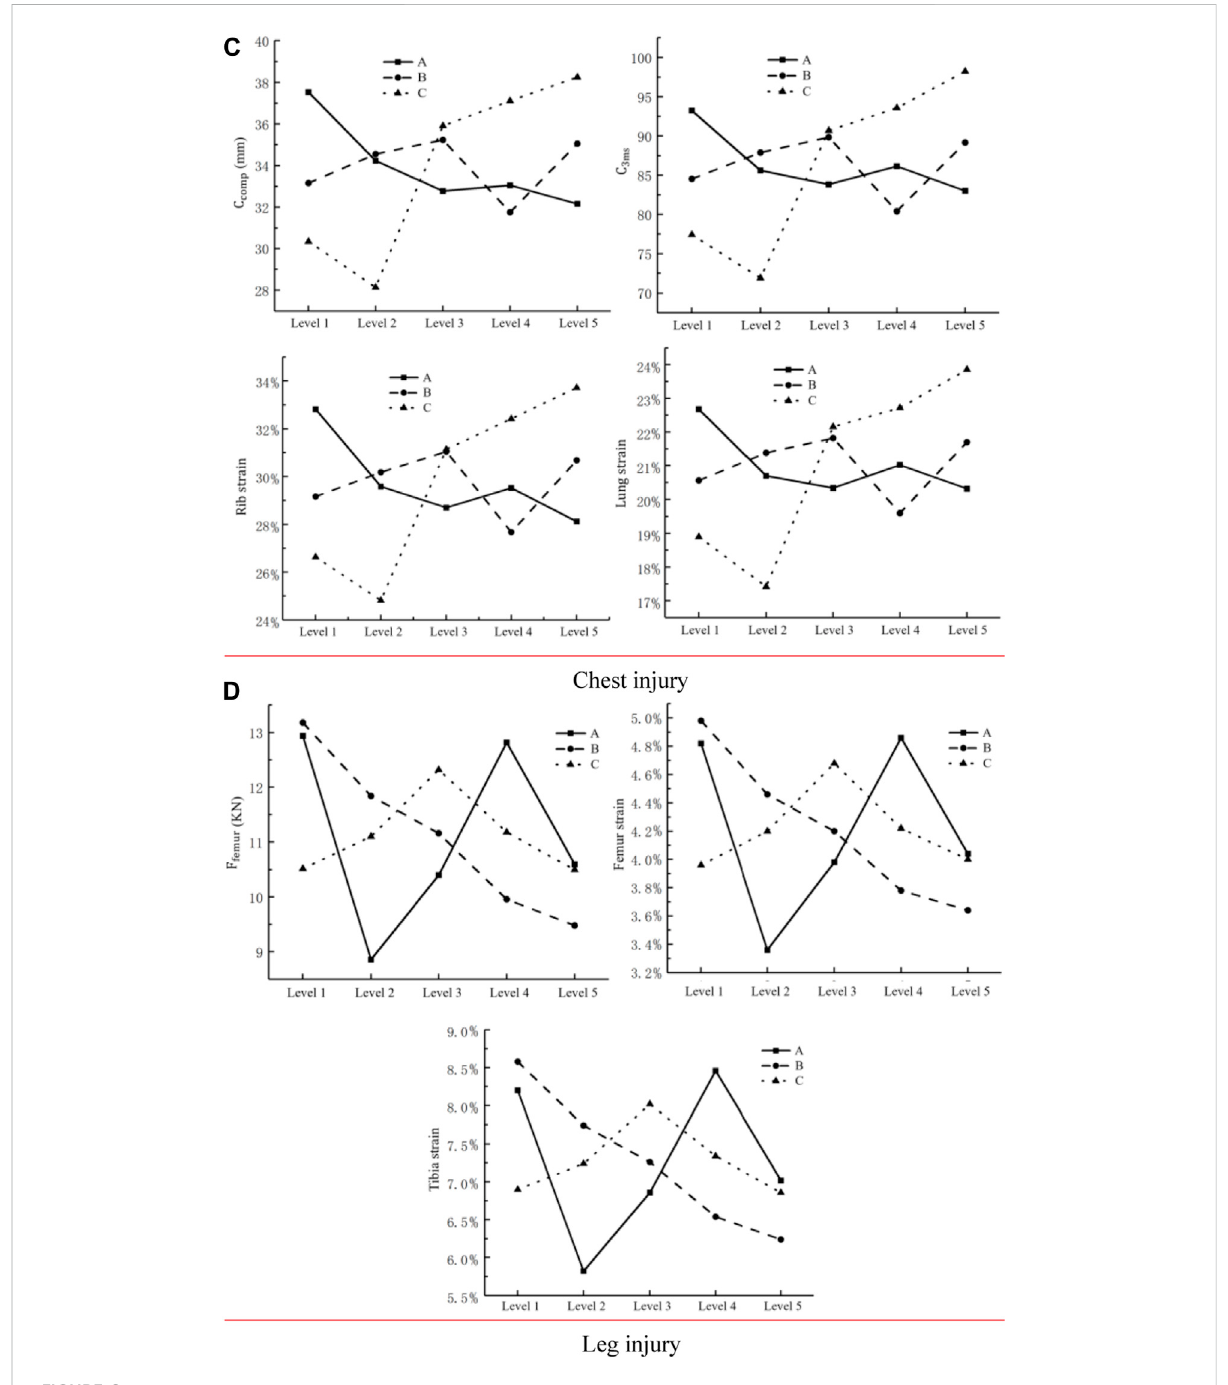
analysis is (cid:2) y . The R 2 determination coef fi cient is in the range of (0, 1). As the value approaches 1, the more accurate the model becomes. RE, ME, and RMSE maximum allowable errors are limited to 0.2, 0.3, and 0.2 in this model, respectively, and